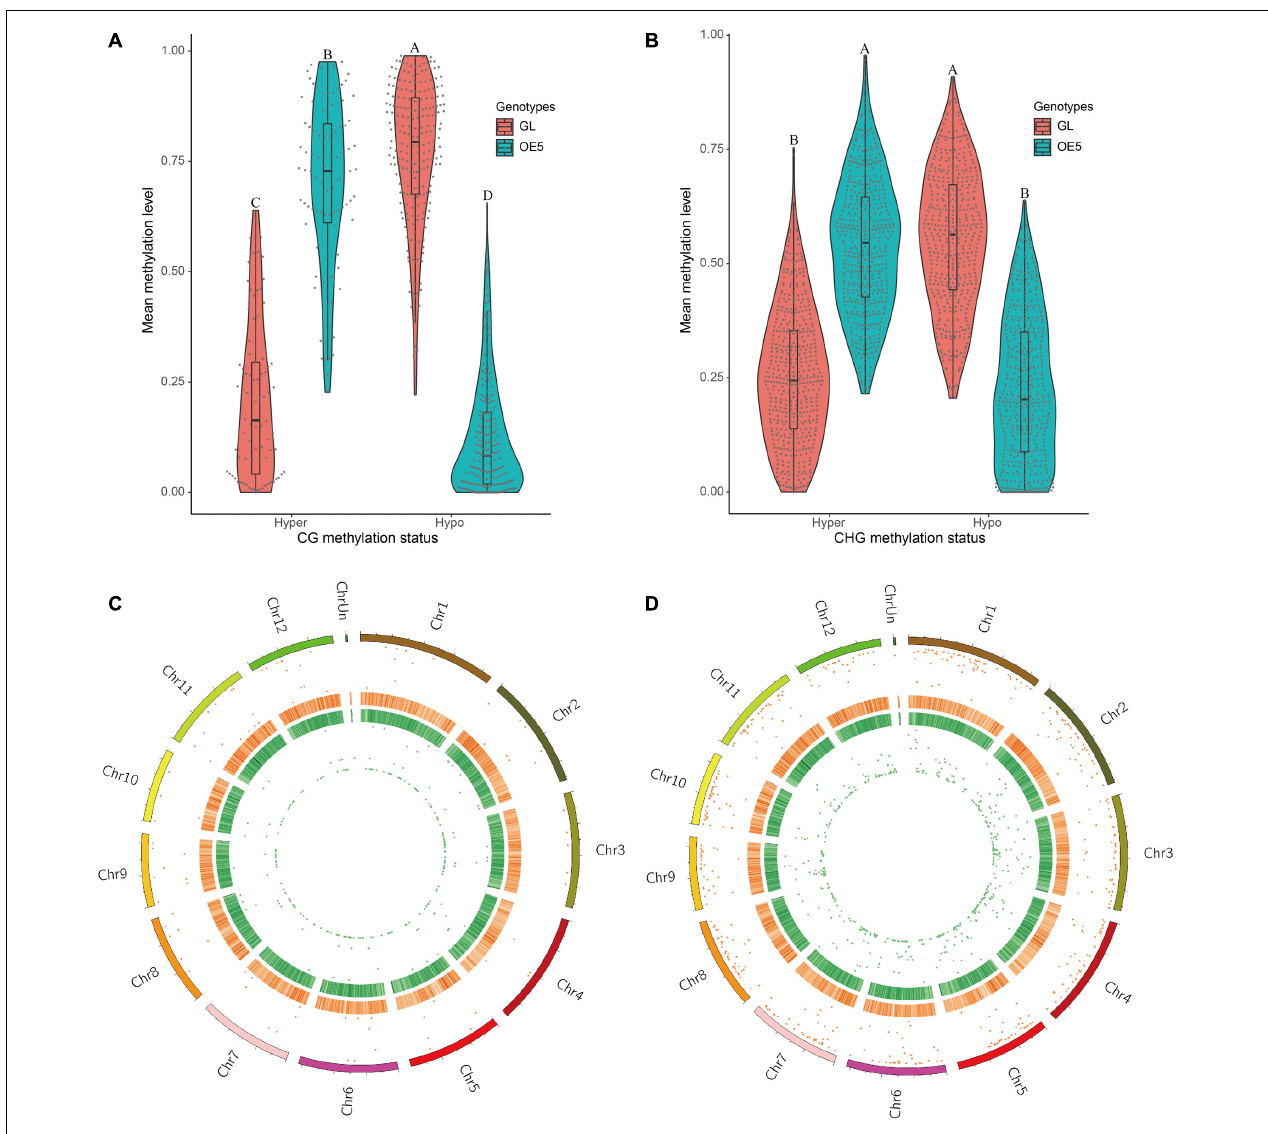
FIGURE 2 | Identification and analysis of differentially methylated regions. Comparisons of hypermethylation and hypomethylation levels in GL and OE5 were plotted for both CG (A) and CHG (B) sequence contexts. Different letters above violin plots represent significant differences at P < 0.01 as revealed by one-way ANOVA analysis (Tukey’s multiple comparison test). DMR distribution on rice chromosomes in CG (C) and CHG (D) sequence contexts is shown. From outer to inner layers, the circular plots represent chromosomes, hyper-DMR distribution (the more outward means higher significance), heatmap of GC content (deeper red colors indicate higher GC content), heatmap of gene density (deeper green colors indicate higher gene density), and hypo-DMR distribution (greater proximity to the center of the circle indicates higher